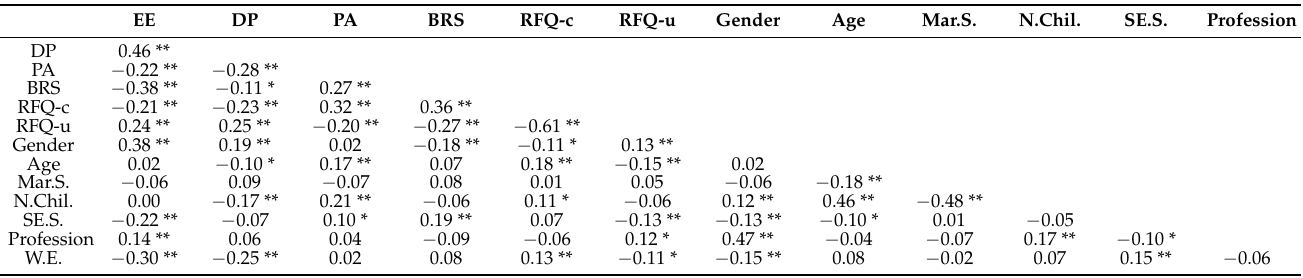
Table 2. Correlations between the investigated